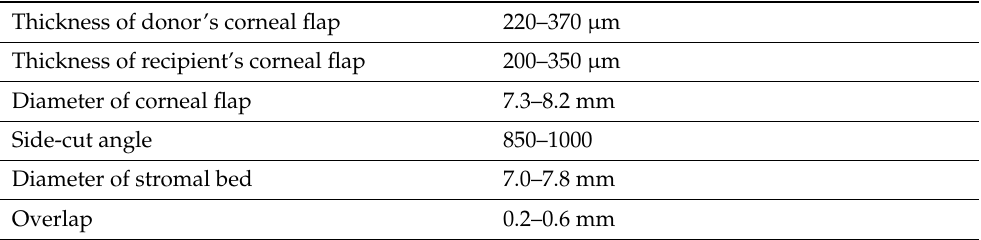
Table 1. The parameters for the cutting